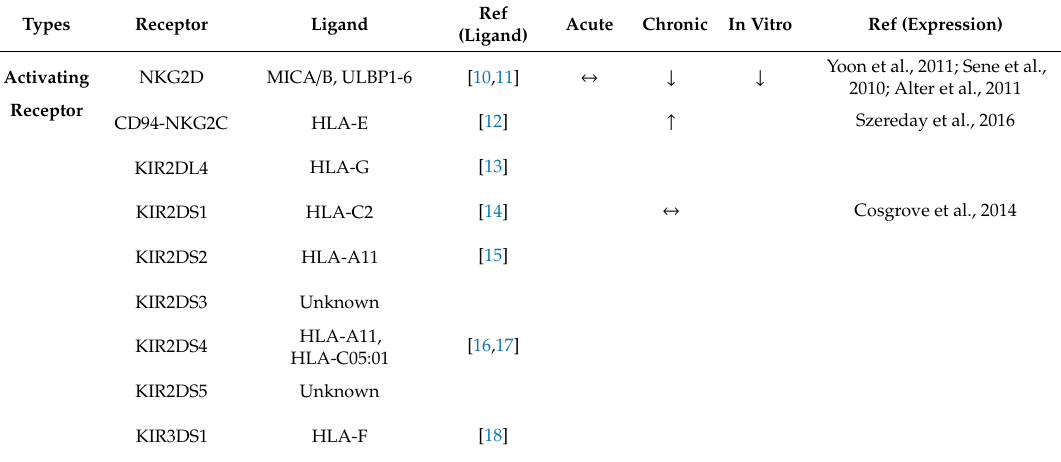
Table 1. Activating and inhibitory human natural killer (NK) cell